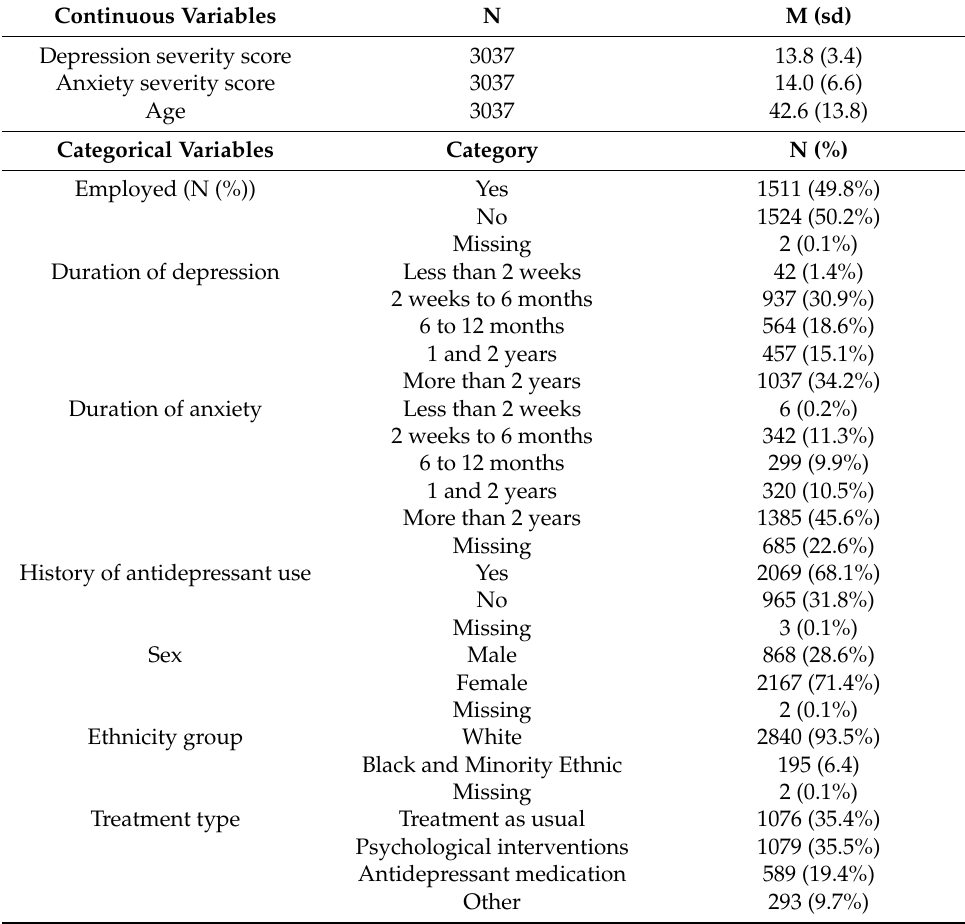
Table 2. Descriptive statistics of the